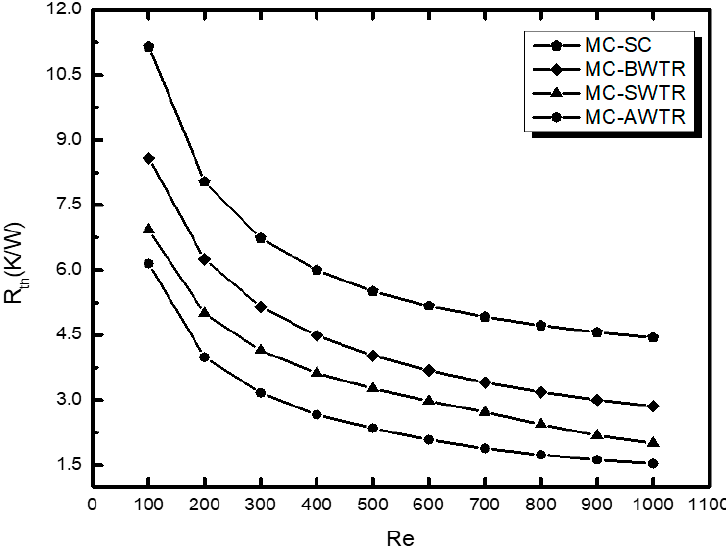
Figure 11. Comparison of total thermal resistance for different wall configurations MCHS.